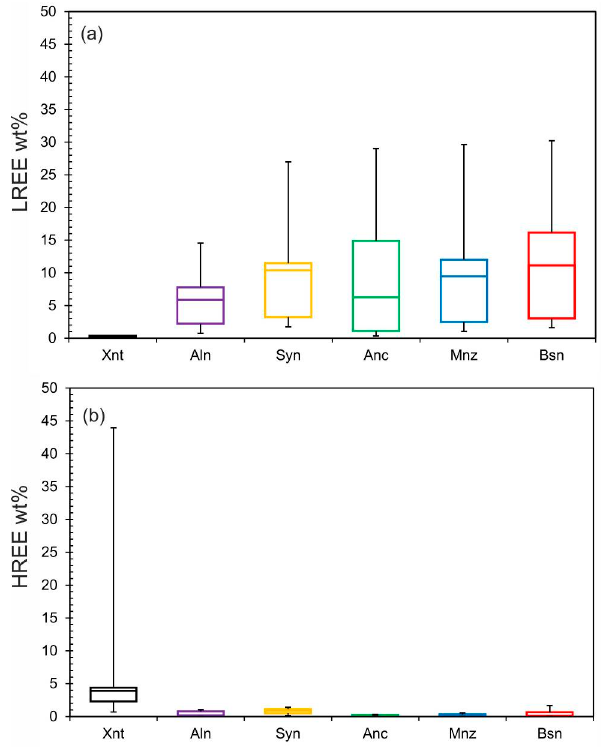
Figure 18. Box plots showing the distributions of REE concentrations in REE-bearing phases of the studied rocks ( a ) Distribution of total LREE; ( b ) Distribution of total HREE.